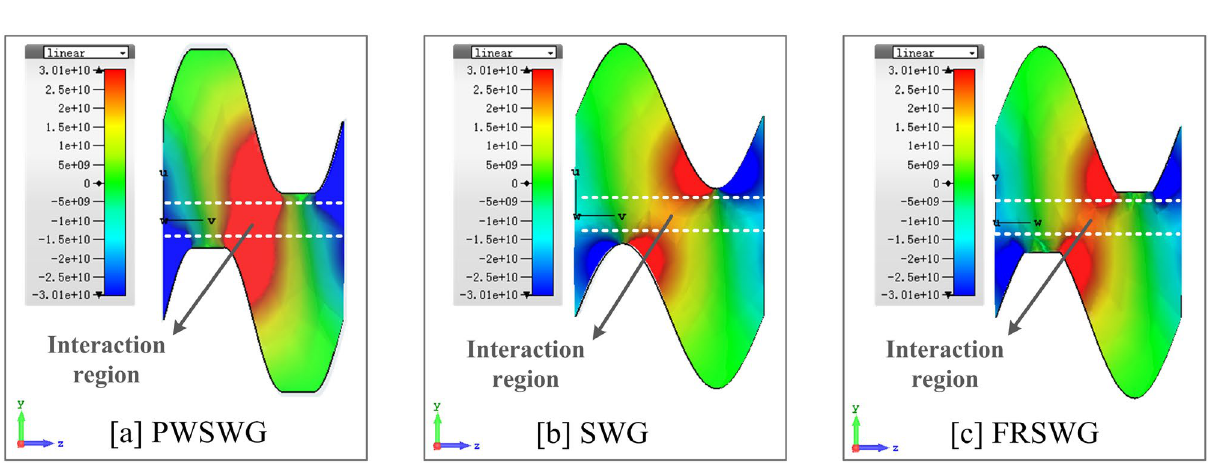
Figure 7. Longitudinal electrical field of the SSRWG SWS, the SWG SWS and the FRSWG SWS at 220